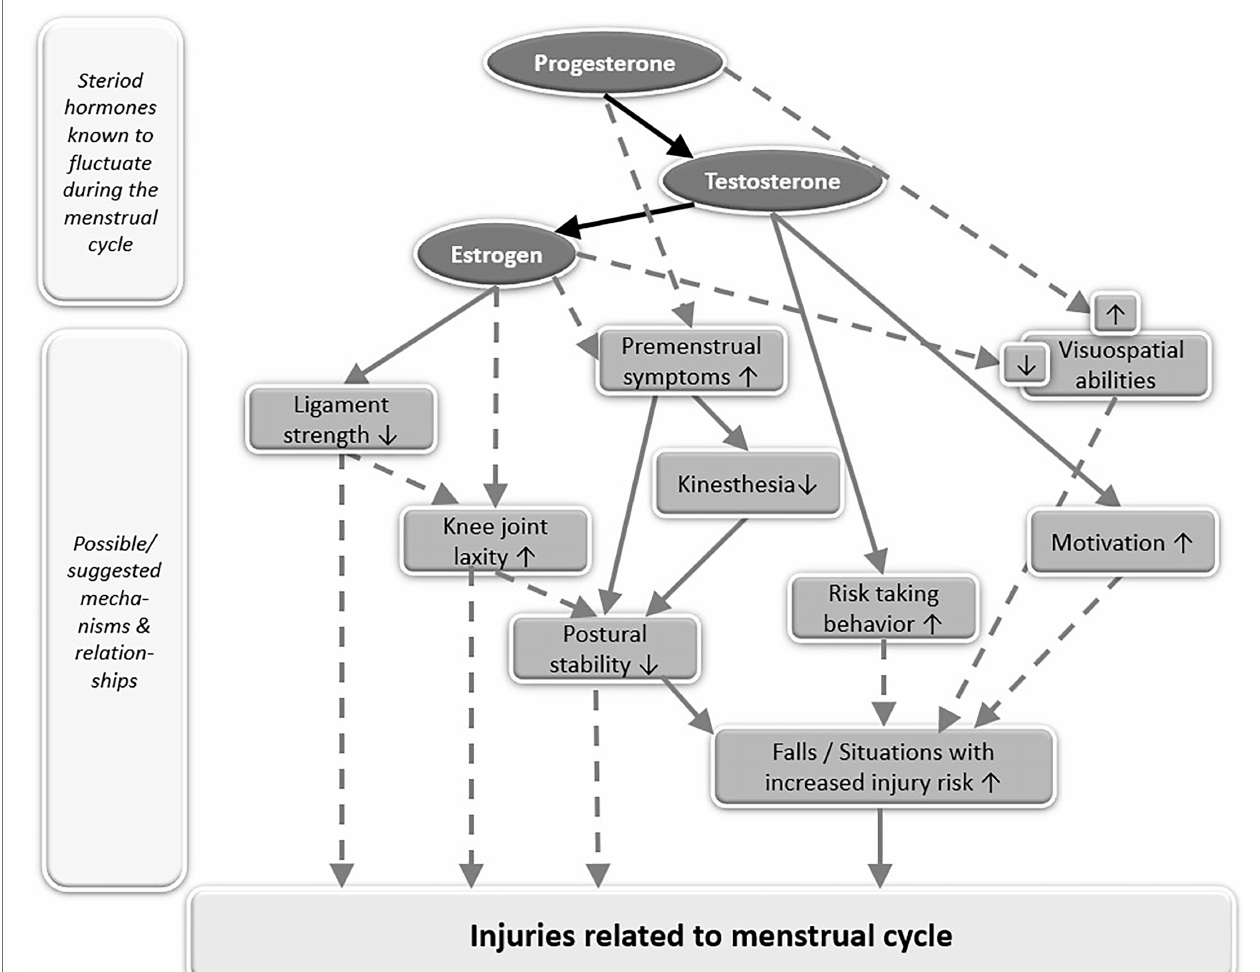
FIGURE 1 | Simplified model of known (solid grey arrows) or suggested (broken grey arrows) relationships between steroid hormones, fluctuating during the menstrual cycle, and their effects on the musculoskeletal and neurophysiological system, assumed to be related to injury risk. Upwards pointing arrows within the boxes symbolize an increase while downwards pointing arrows within the boxes symbolize a decrease. Black arrows connecting progesterone, testosterone, and estrogen symbolize the biosynthetic pathway of steroid